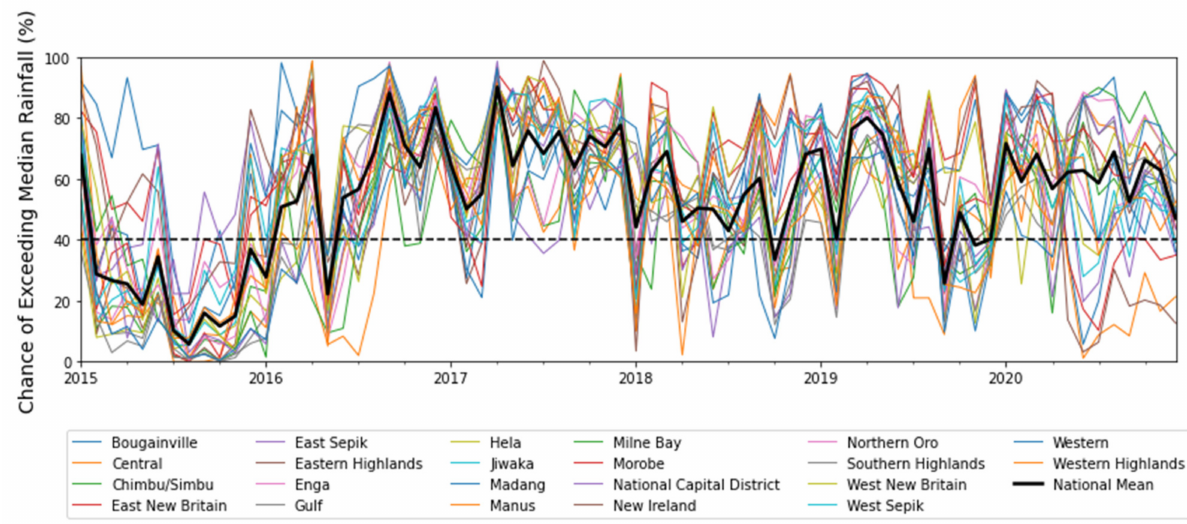
Figure 9. Chance of exceeding median rainfall for the next month averaged over 22 PNG provinces from 2015 to 2020 and compared to the national mean (in bold